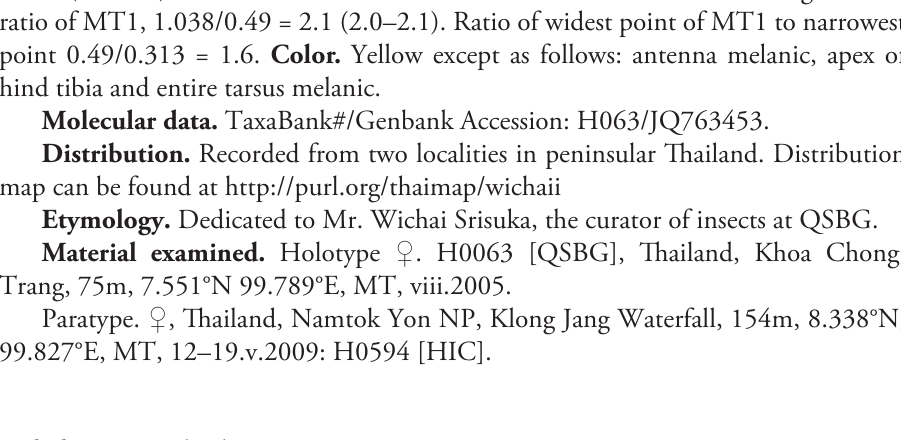
Diagnosis. Hind tibia mostly pale except apex black; hind femur all melanic; mes- oscutum entirely pale; median ocellus about as wide as or wider than space between lateral ocelli.